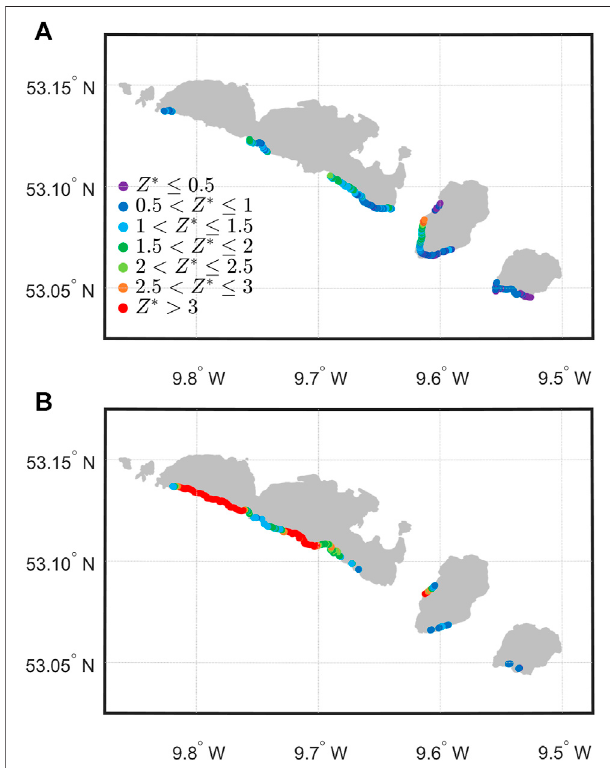
FIGURE2| AranIslandsdimensionlesselevationsshowing (A) almostall low Z* locations (cold colors) host CBD; whereas the locations without CBD (B) are predominantly at higher